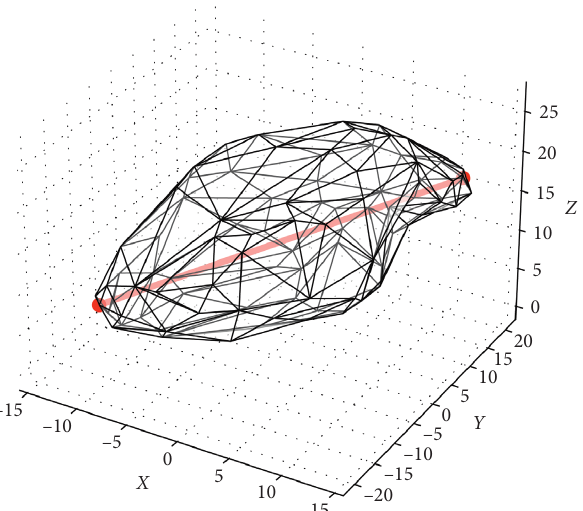
Figure 7: Schematic diagram of long-axis extraction of the in- tracranial hematoma